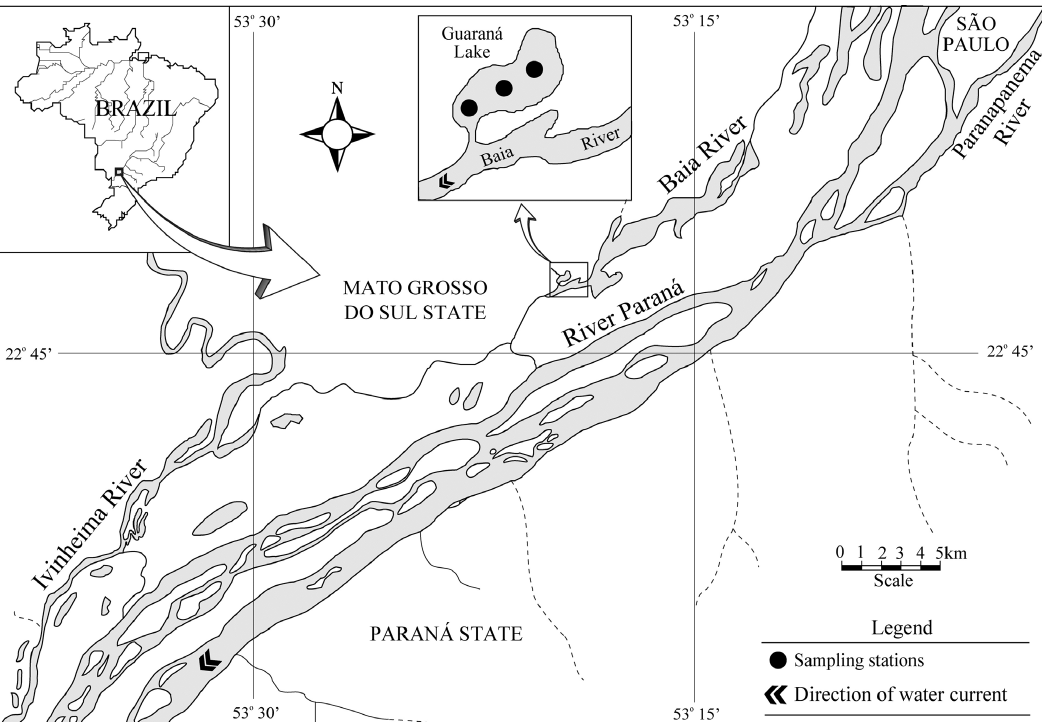
Figure 1. Study area showing the sampling sites at the Guaraná